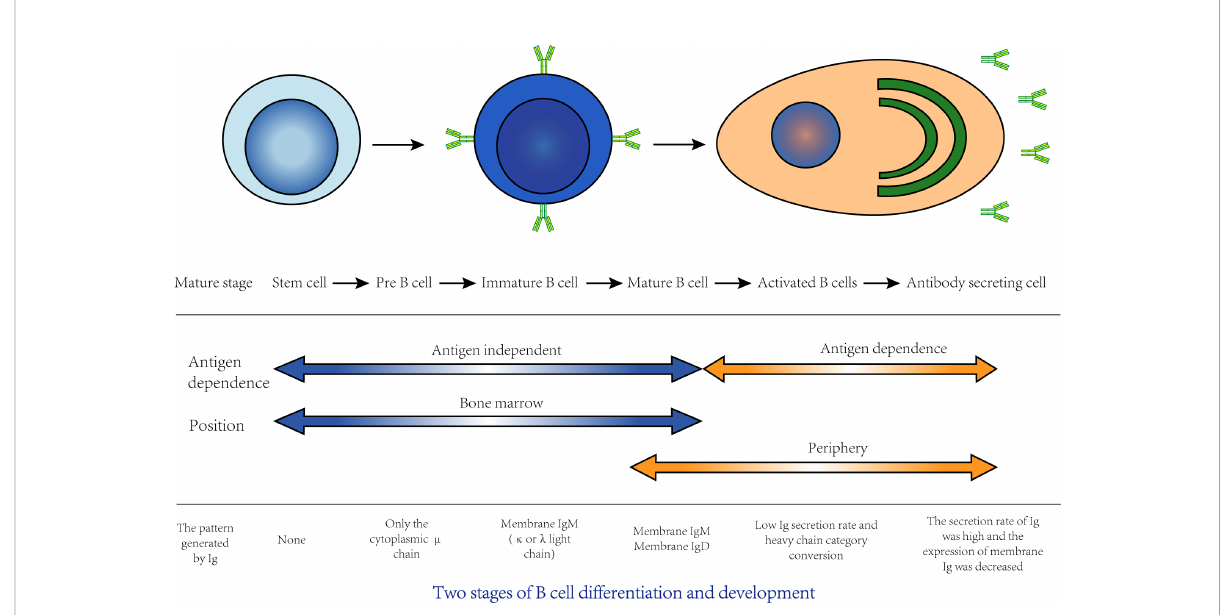
FIGURE 3 The differentiation and development of B cells can be divided into two stages: central development and peripheral development. Central development: Stem cells in bone marrow go through the stage of pre-B cells and immature B cells and fi nally develop into mature B cells, which is also known as the antigen-independent stage of B cell development. This process is closely related to bone marrow hematopoietic microenvironment. Cytokines and adhesion factors in bone marrow stroma are key factors involved in development. Peripheral development: Mature B cells migrate to peripheral immune organs. If it is stimulated by antigen, B cells will proliferate, differentiate into plasma cells and secrete speci fi c antibodies, which is also known as the antigen-dependent period of B cell development. Most of these activated B cells differentiate into plasma cells that secrete speci fi c antibodies, and a few differentiate into memory B